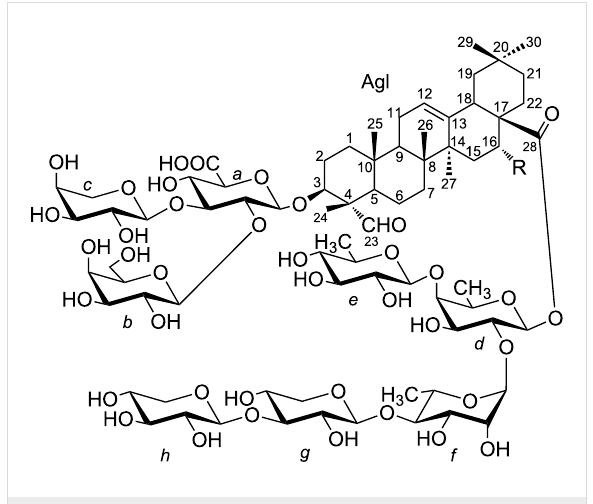
Figure 1: Saponins from A. gypsophiloides 1 , R = OH and 2 , R =